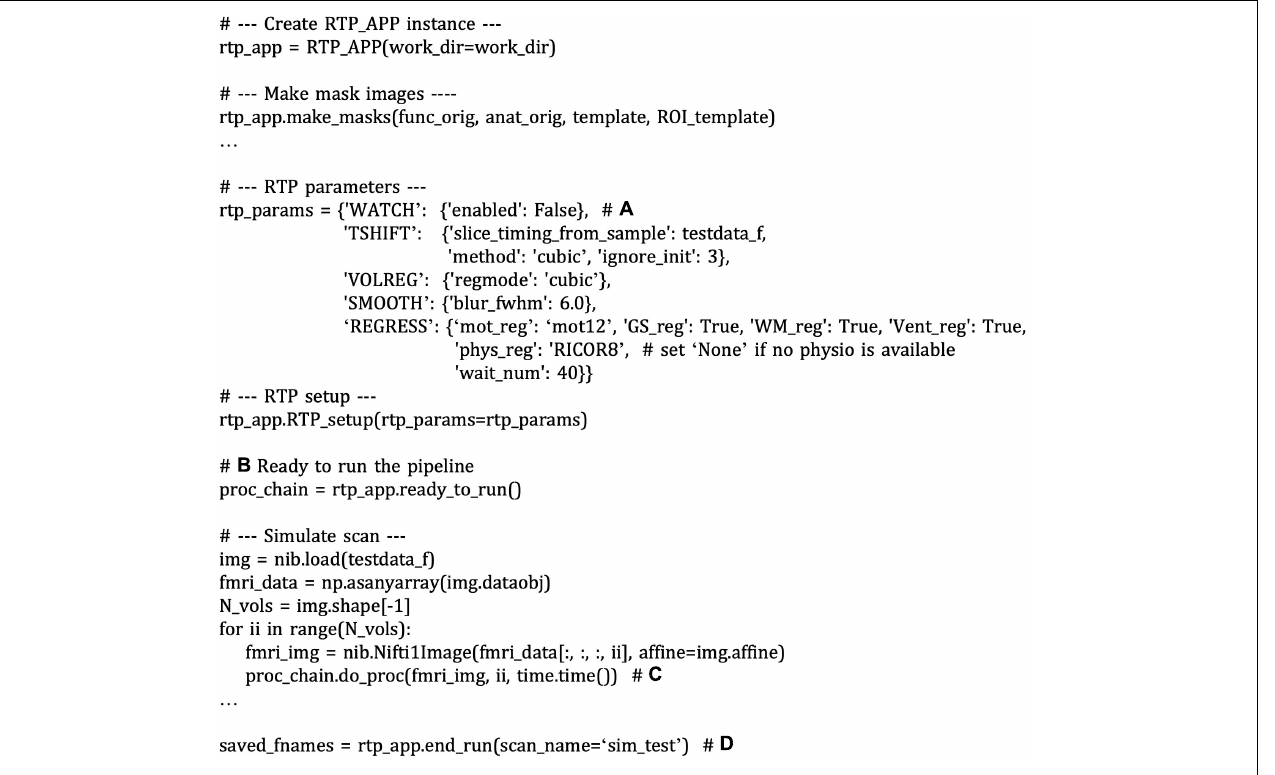
FIGURE 8 | A snippet of an example script of running a real-time fMRI processing simulation with RTPSpy. The comments with bold alphabet indicate a part of the script explained in the main text. The pipeline creation is the same as shown in Figure 6 except for disabling the RTP_WATCH module (A) and returning the pipeline object from the “ ready_to_run ” method (B) . The simulation can proceed with feeding the Nibabel Nifti1Image object to the “ do_proc ” method of the pipeline (C) . Calling the “ end_run ” method closes the pipeline and returns the saved filenames (D)